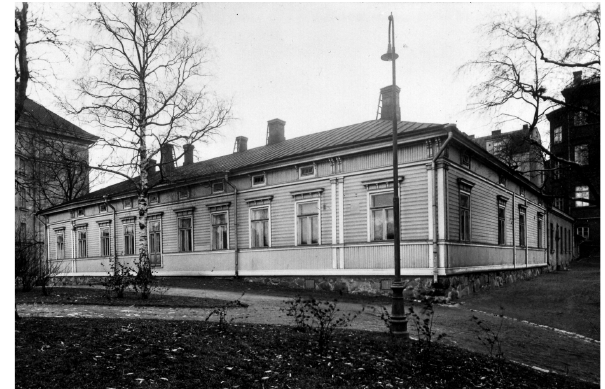
Figure 3. The main building of the Helsinki magnetic observatory in the 1930s. The building was set up in 1841 and demolished in the early 1960s. A new building for the Institute was set up in 1966 (Photo: